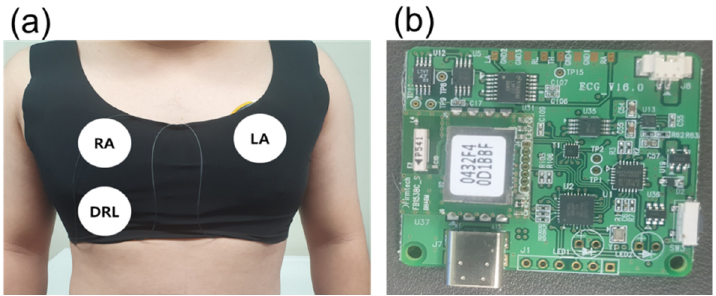
Figure 5. Measurement environment. ( a ) Location of capacitive electrode and ( b ) ECG measurement board.